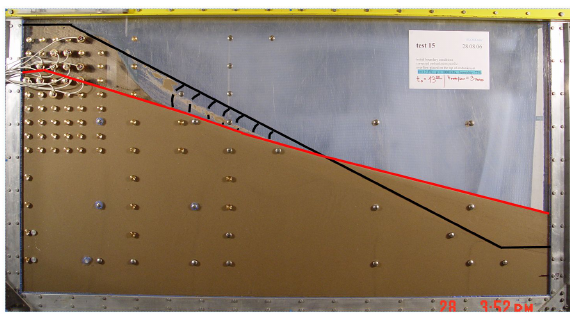
Figure 6: Embankment destruction mechanism (type 1 model) - test F15 - a test with water overflow through the crown of the flood embankment about q ~ 4 ml/s.